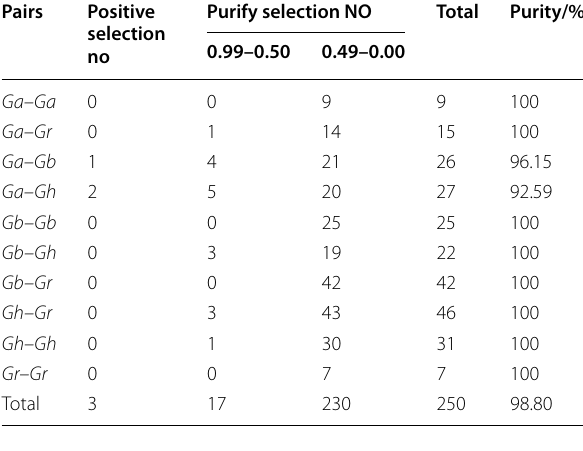
Table 1 Distribution of duplicate gene pairs in selection pressure analysis from four Gossypium species Pairs Positive selection